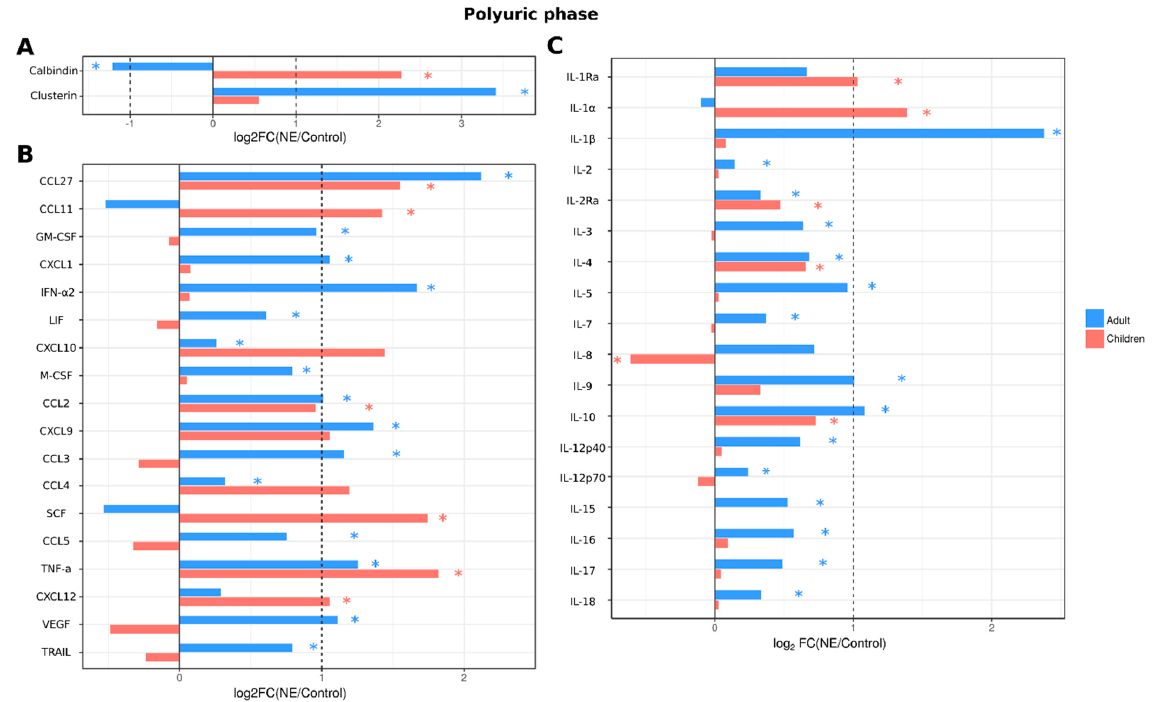
Figure 6. Analysis of serum cytokine and kidney toxicity markers in adults and children diagnosed with NE in polyuric phase. The Bio-Plex (Bio-Rad, Hercules, CA, USA) multiplex magnetic bead- based antibody detection kit was used to measure ( A ) markers of kidney toxicity in the urine; ( В ) serum chemokines or ( С ) serum interleukins in adults ( n = 129) and children ( n = 11). Data are presented as Log2 fold change in comparison to non-NE control samples. Asterisks denote statistical significance determined by Kruskal-Wallis test with BH adjustment ( p < 0.05). Dotted line indicates fold change of 1.